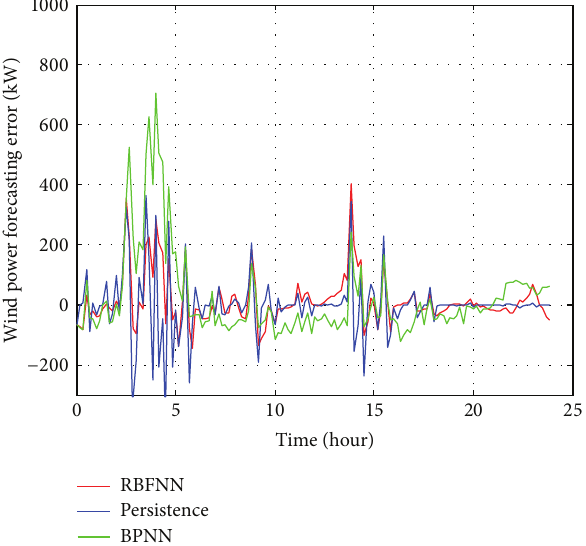
Figure 7: The forecasting error curve of three methods for typical winter day.